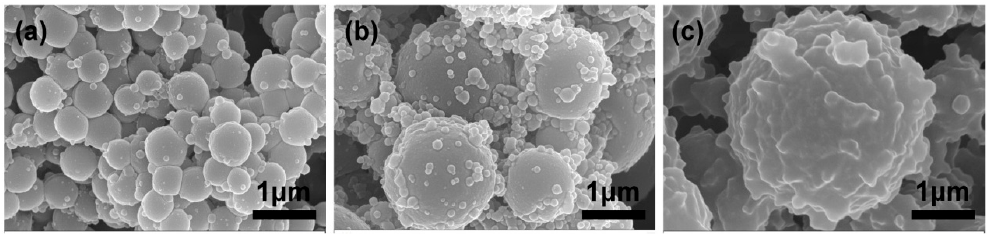
Figure 9. SEM micrographs of ( a ) microencapsulated PAE; ( b ) microencapsulated PAE/TO and ( c ) microencapsulated TO.